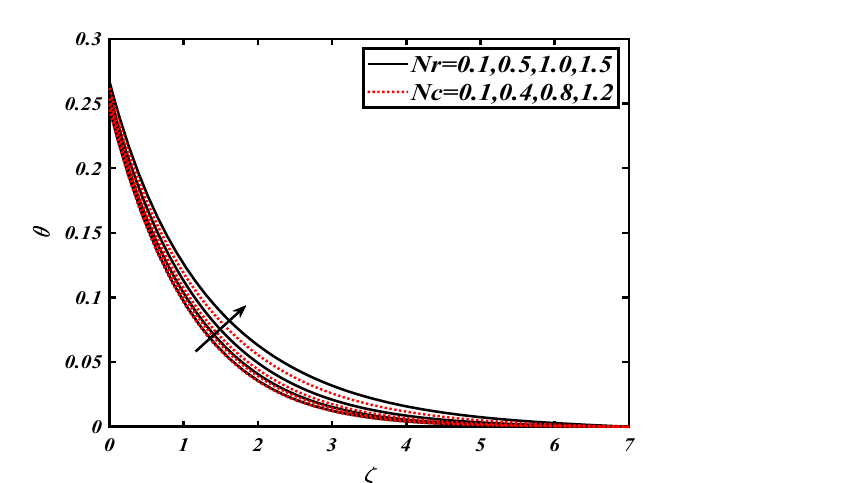
Figure 5. Illustration of Nr and Nc overtemperature θ when Pr = 2.0, Rd = 0.4, γ 2 = 0.3, Nb = 0.2, Nt = 0.3, S = 0.5, (cid:31) = 0.5, β = 0.2